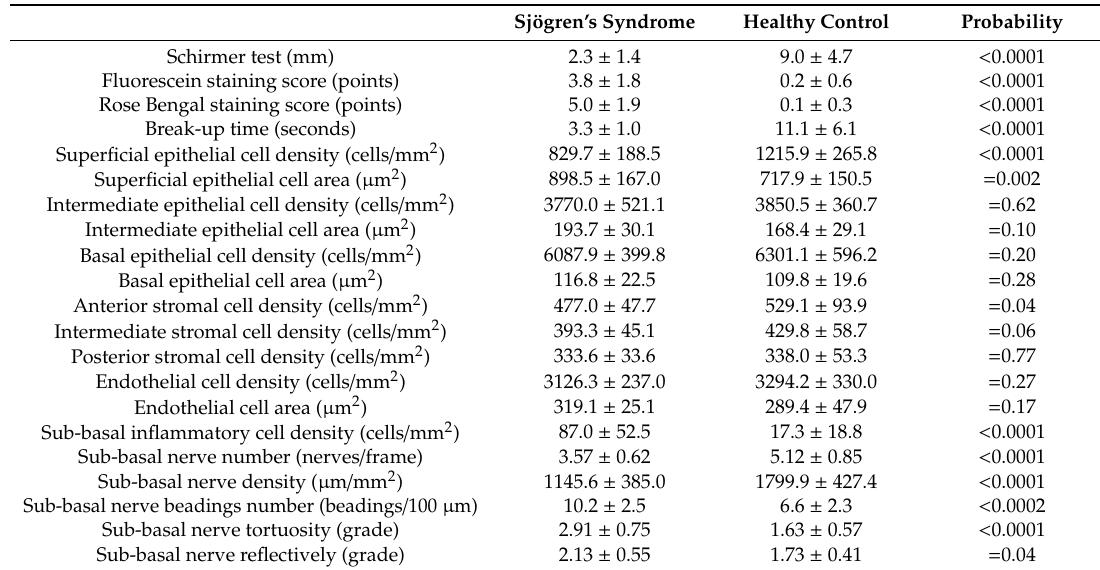
Table 1. Comparisons of tear functions, ocular surface vital staining scores, and in vivo laser-scanning confocal microscopic